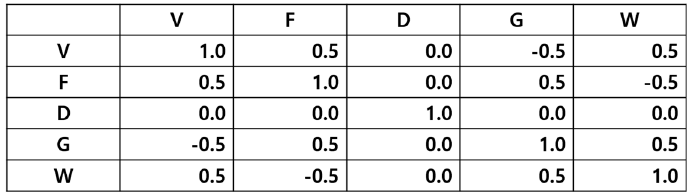
Figure 8. Qualia Matching Rule.